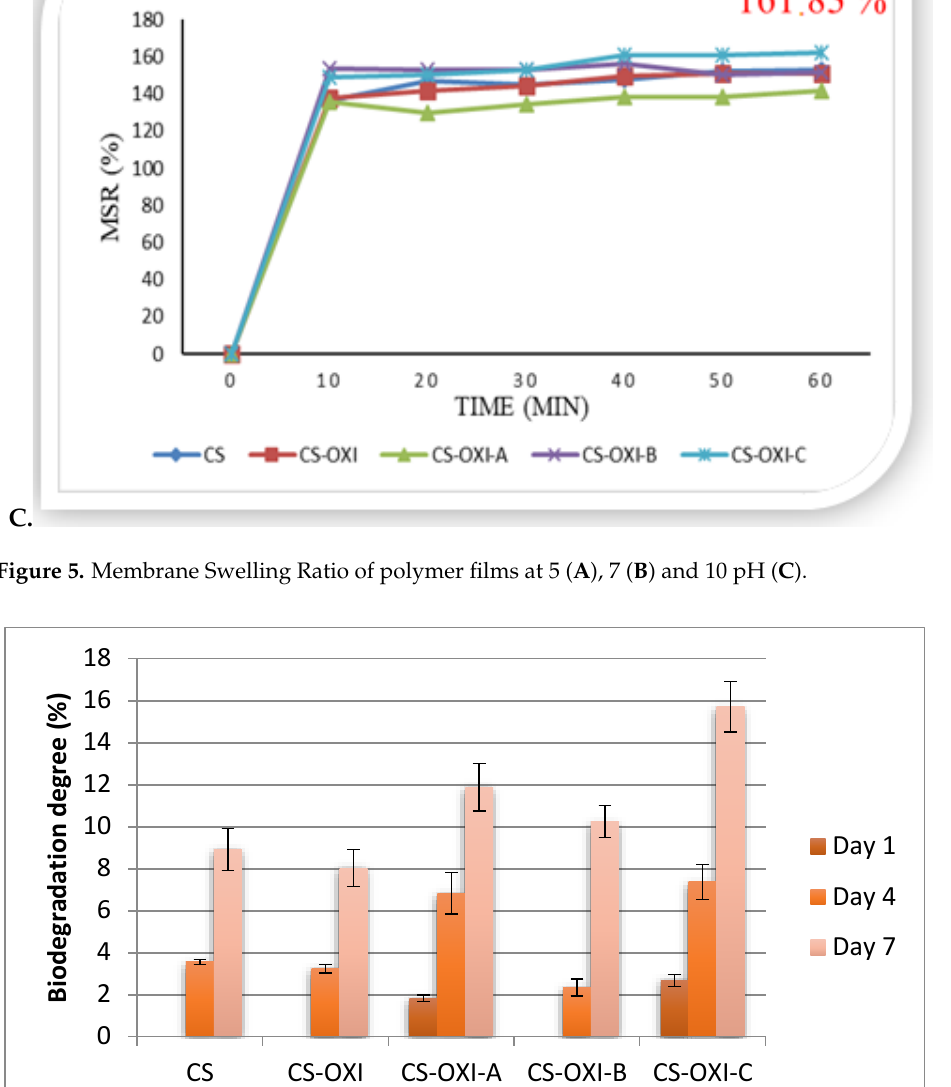
Figure 5. Membrane Swelling Ratio of polymer films at 5 ( A ), 7 ( B ) and 10 pH ( C ).